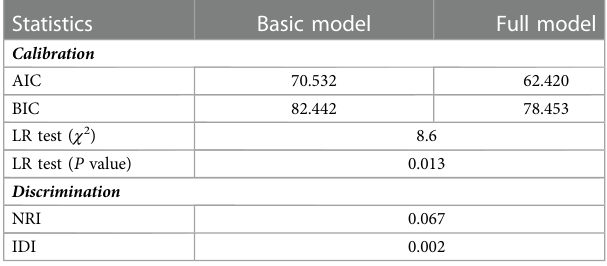
TABLE 2 Identi fi cation of potential factors for malignant VVS before and after adjustment.